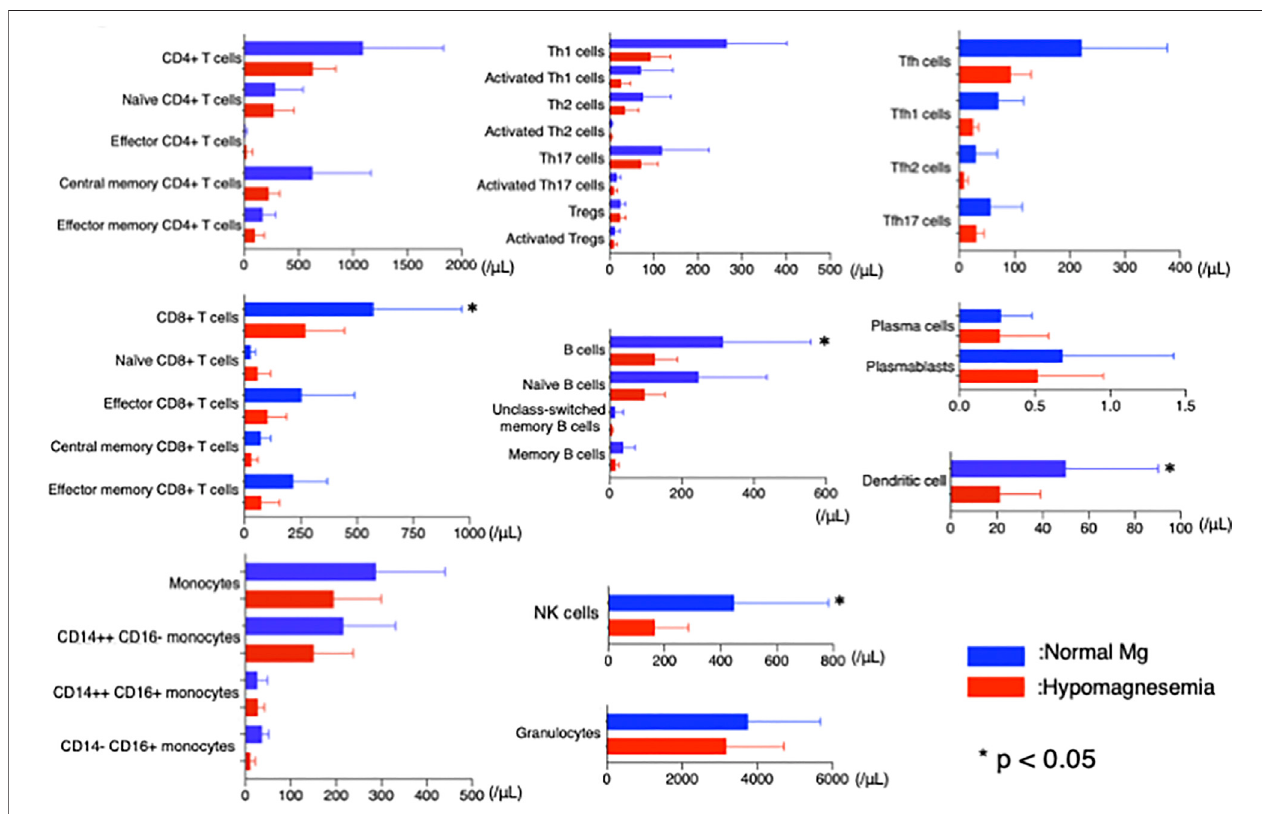
FIGURE 5 | Flow cytometric analysis in patients with and without hypomagnesemia. Lower cells counts were observed for CD8 + T cells, CD19 + B cells, NK cells, anddendriticcellsinpatientswithhypomagnesemiathaninpatientswithnormalMglevels( p (cid:1) 0.03, p (cid:1) 0.02, p (cid:1) 0.02,and p (cid:1) 0.03,respectively).NK,naturalkiller;Mg,